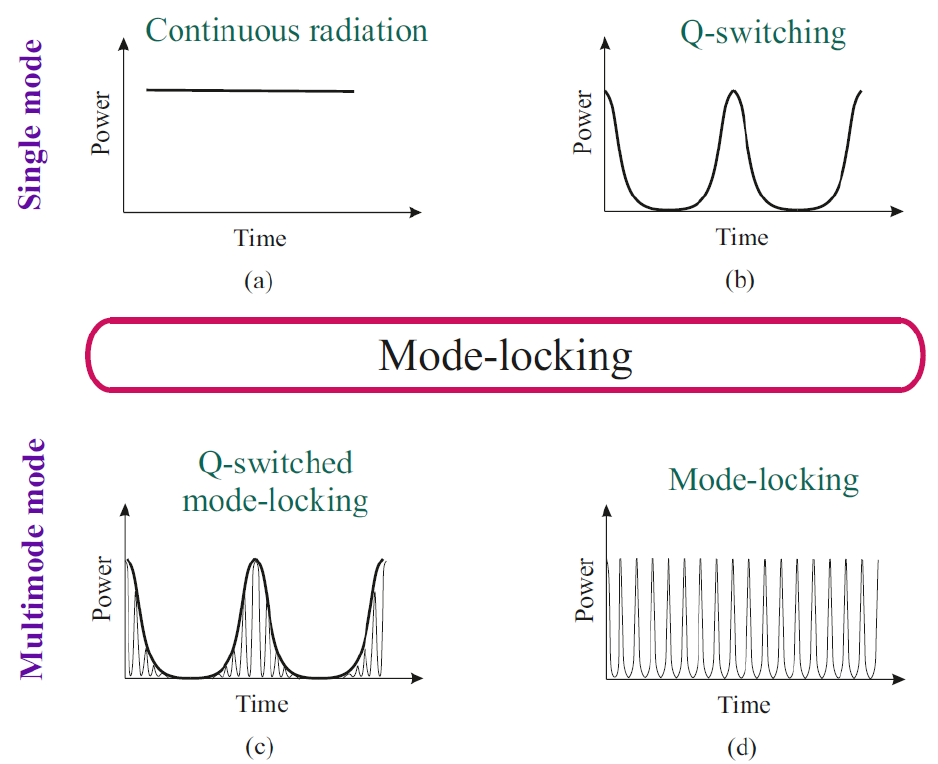
Figure 10. Various modes of operation of lasers using saturable absorbers: ( a ) continuous lasing; ( b ) Q-switching mode; ( c ) Q-switched mode with mode-locking; ( d ) mode-locking.